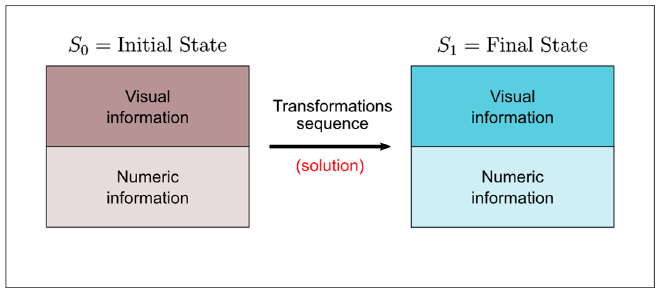
Figure 4. Model of learning exercise.